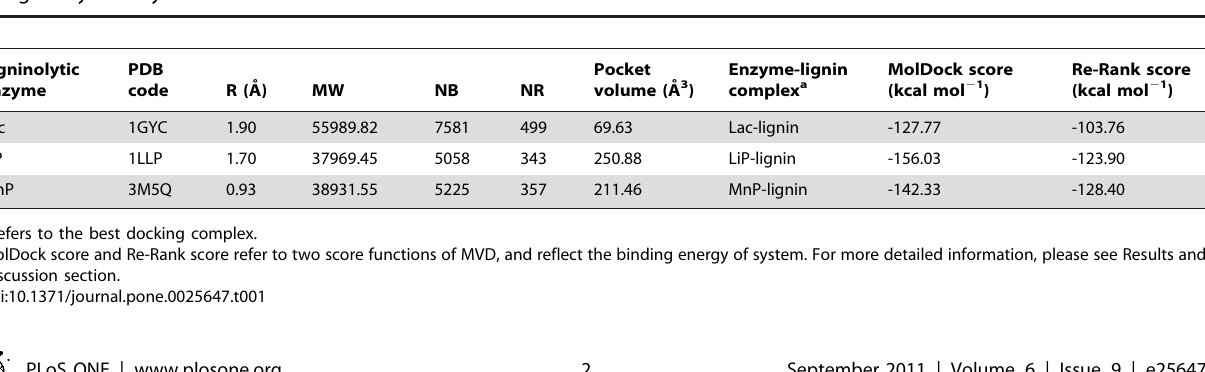
Table 1. Overview of ligninolytic enzyme PDB codes, resolutions (R), molecular weight (MW, g/mol), number of bonds (NB), number of residues (NR), and MolDock score and Re-Rank score of the best docking poses for lignin ligand into the biding pockets of ligninolytic